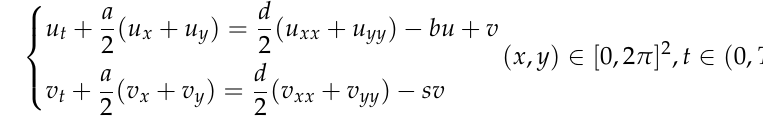
Figure 3. Numerical solutions of the present HOC scheme for Problem 2 when h = 1 (a) T = 0.3; (b) T = 0.6; (c) T = 0.9; (d) T = 1.2.